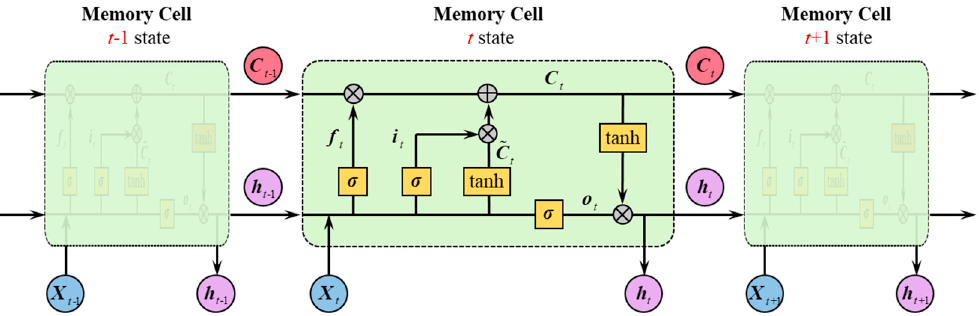
Figure 1. The internals of a Long Short-Term Memory (LSTM) memory cell.